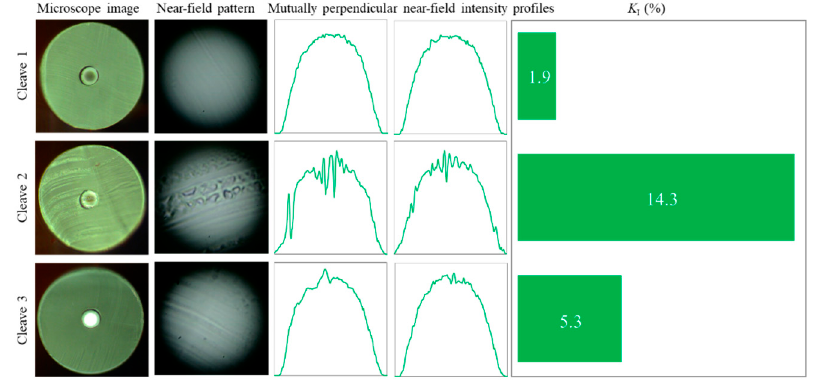
Figure 6. Three consecutive cleaves (obtained by Bic razor blade): end-face quality is not stable cleave by cleave.